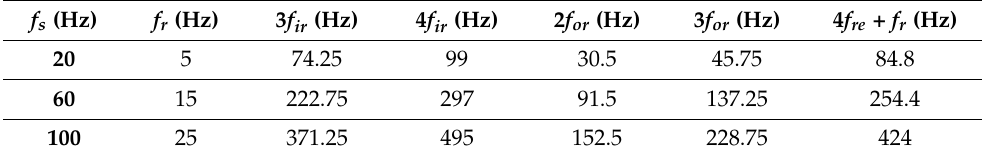
Table 1. Examples of frequency values for damage harmonics.